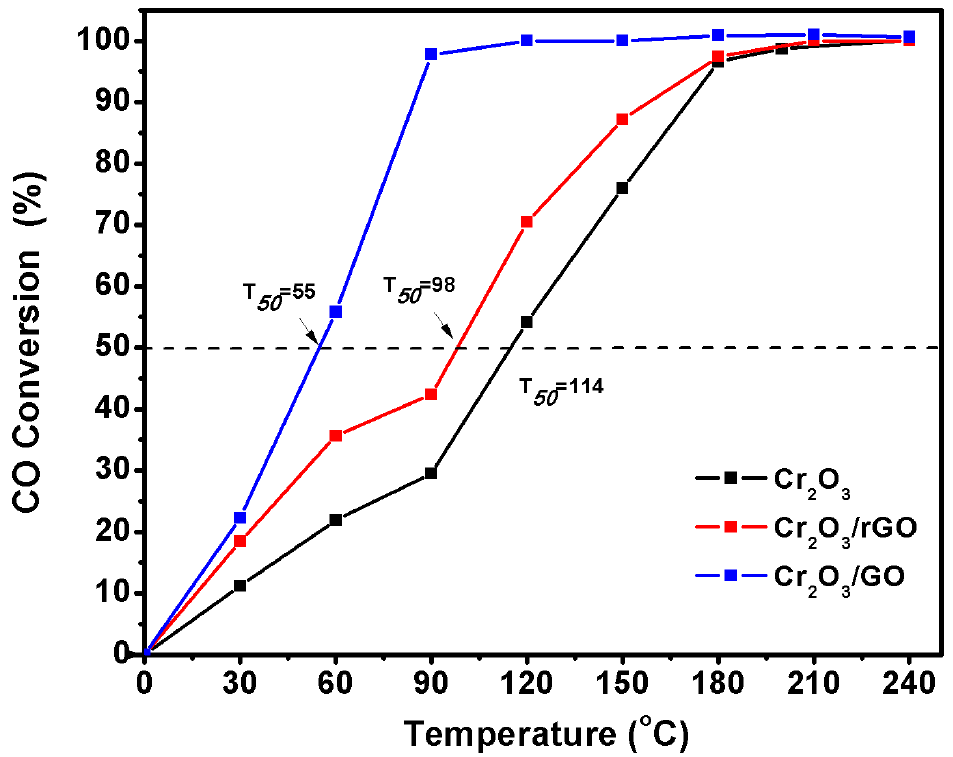
Figure 7. Catalytic activity for CO oxidation of Cr 2 O 3 NPs alone and the hybrids Cr 2 O 3 / rGO and Cr 2 O 3 /GO catalysts in the temperature range of 30−240 °C.